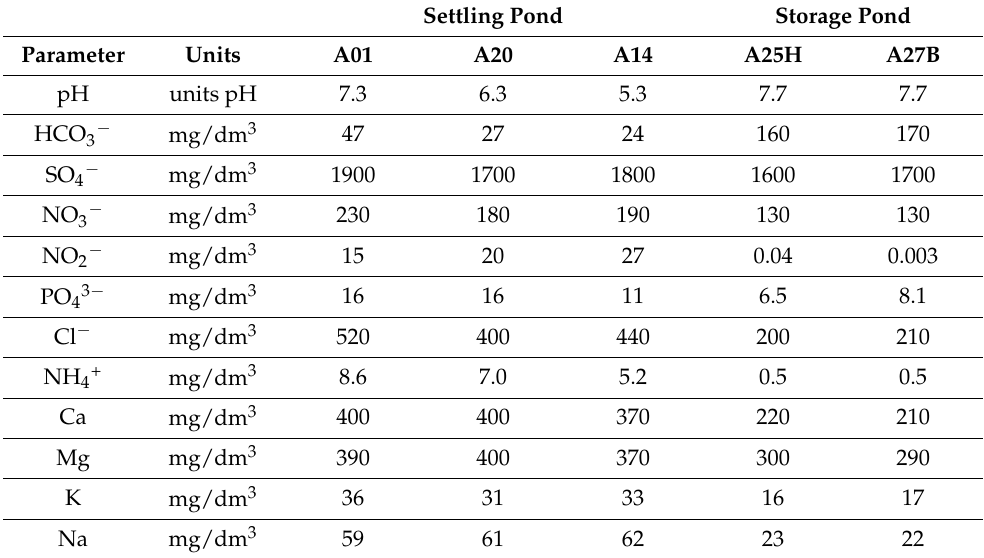
Composition of solutions from the settling pond and storage pond for thermodynamic